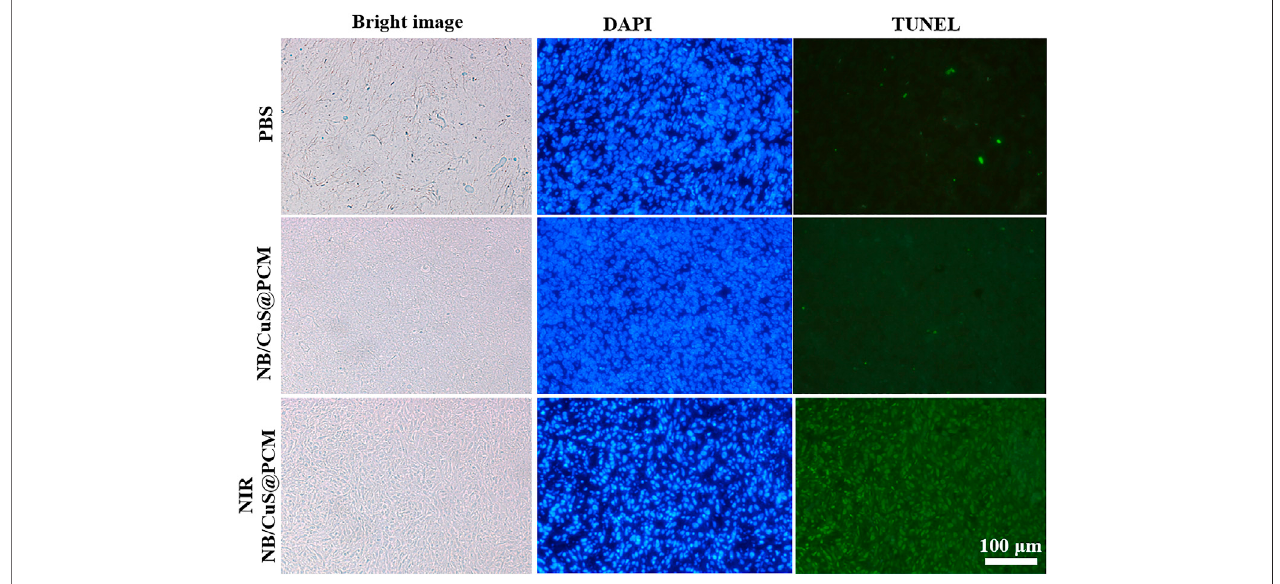
FIGURE 6 | TUNEL assay of tumor tissue after 1 day of treatment. Nucleus was labeled by DAPI with blue fl uorescence. The DNA nick was labeled by FITC modi fi ed dUTP with green fl uorescence.